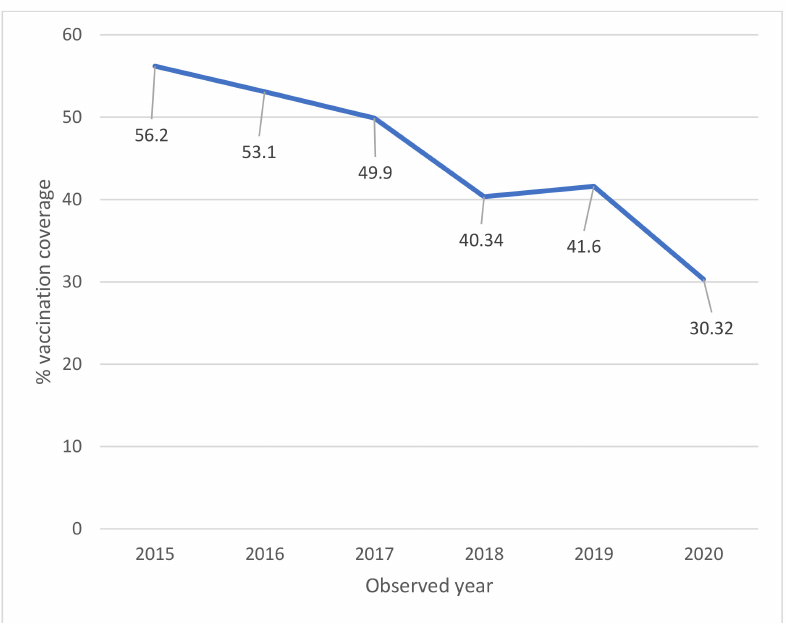
Figure 3. HPV vaccination coverage in Italy. Time trend for complete cycle per year (females). Data updated to 31 December 2020 (modified by